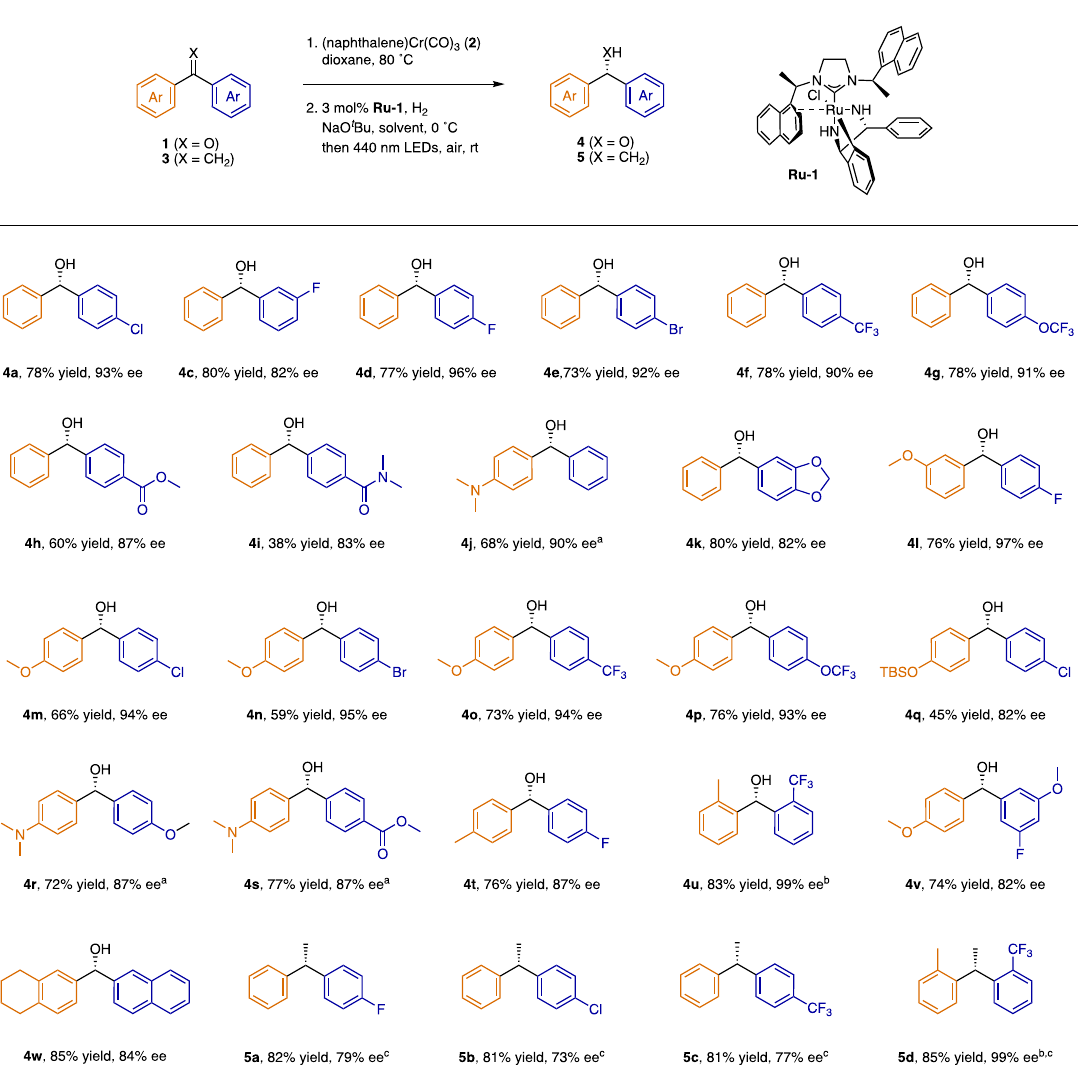
Fig. 4 | Substrate scope of Ru-catalyzed hydrogenation reactions. Synthesis of compounds bearing a chiral gem -diaryl motif from either 1,1-diarylethylenes or benzophenones by a sequence involving selective arene exchange and stereo- selectiveasymmetrichydrogenation.Reactionconditions,unlessotherwisestated: (1) 1 (0.2mmol), 2 (0.3mmol), dioxane (2mL), 80°C, 24h. (2) Ru-1 (3mol%),